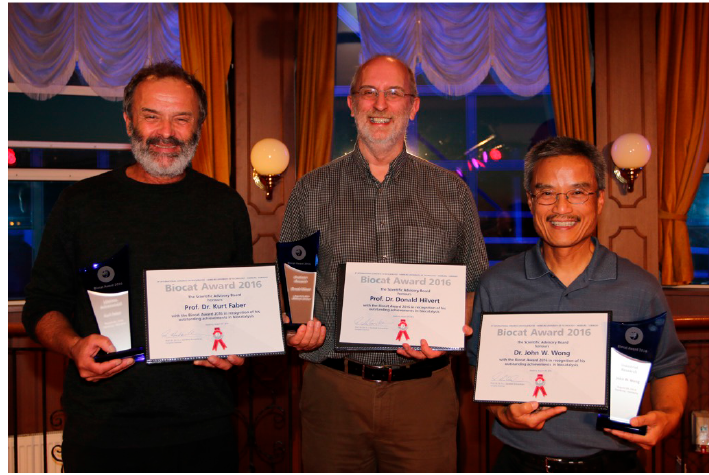
Figure 3. Biocat2016 awardees. Left: Kurt Faber received the biocat award for “Lifetime achievement”. Middle: Donald Hilvert was awarded in the category “Science in academia”. Right: John Wong was honored with the biocat award in the category “Industry”.